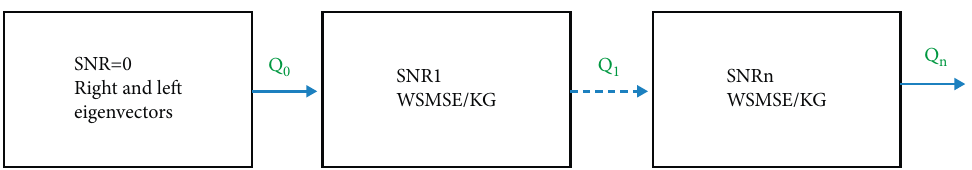
Figure 3: Deterministic annealing variant